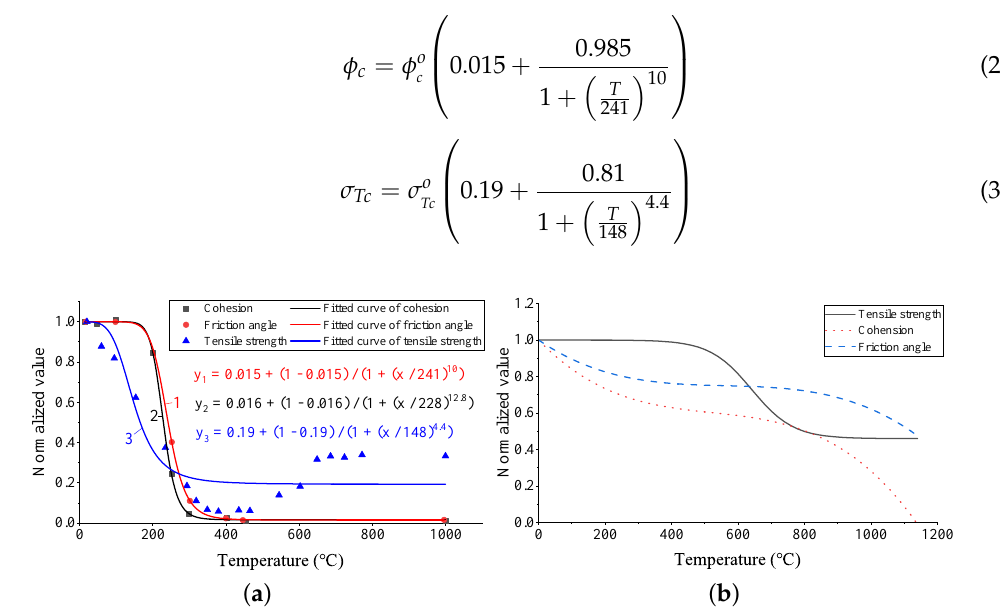
Figure 2. Mechanical parameters of coal and sandstone with variable temperature (after Otto and Kempka [11], Liu et al. [49]). ( a ) Coal; ( b ) Sandstone.